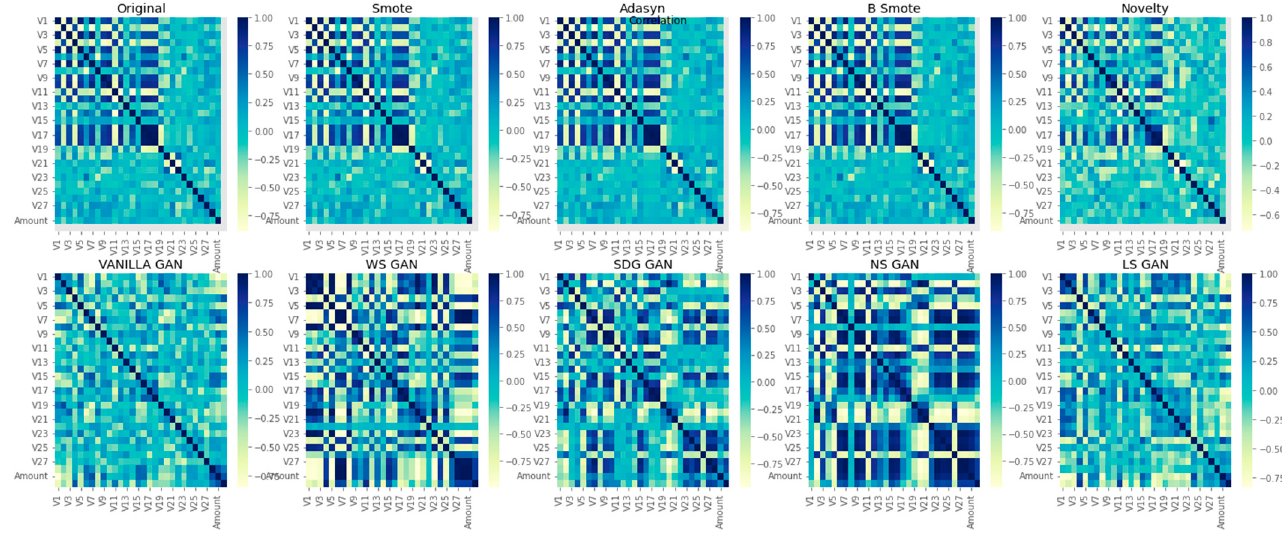
Figure 13. Correlation comparison of Original Data, SMOTE, ADASYN, B‑SMOTE, Novelty K‑ CGAN, Vanilla GAN, WS GAN, SDG GAN, NS GAN, and LS GAN methods.